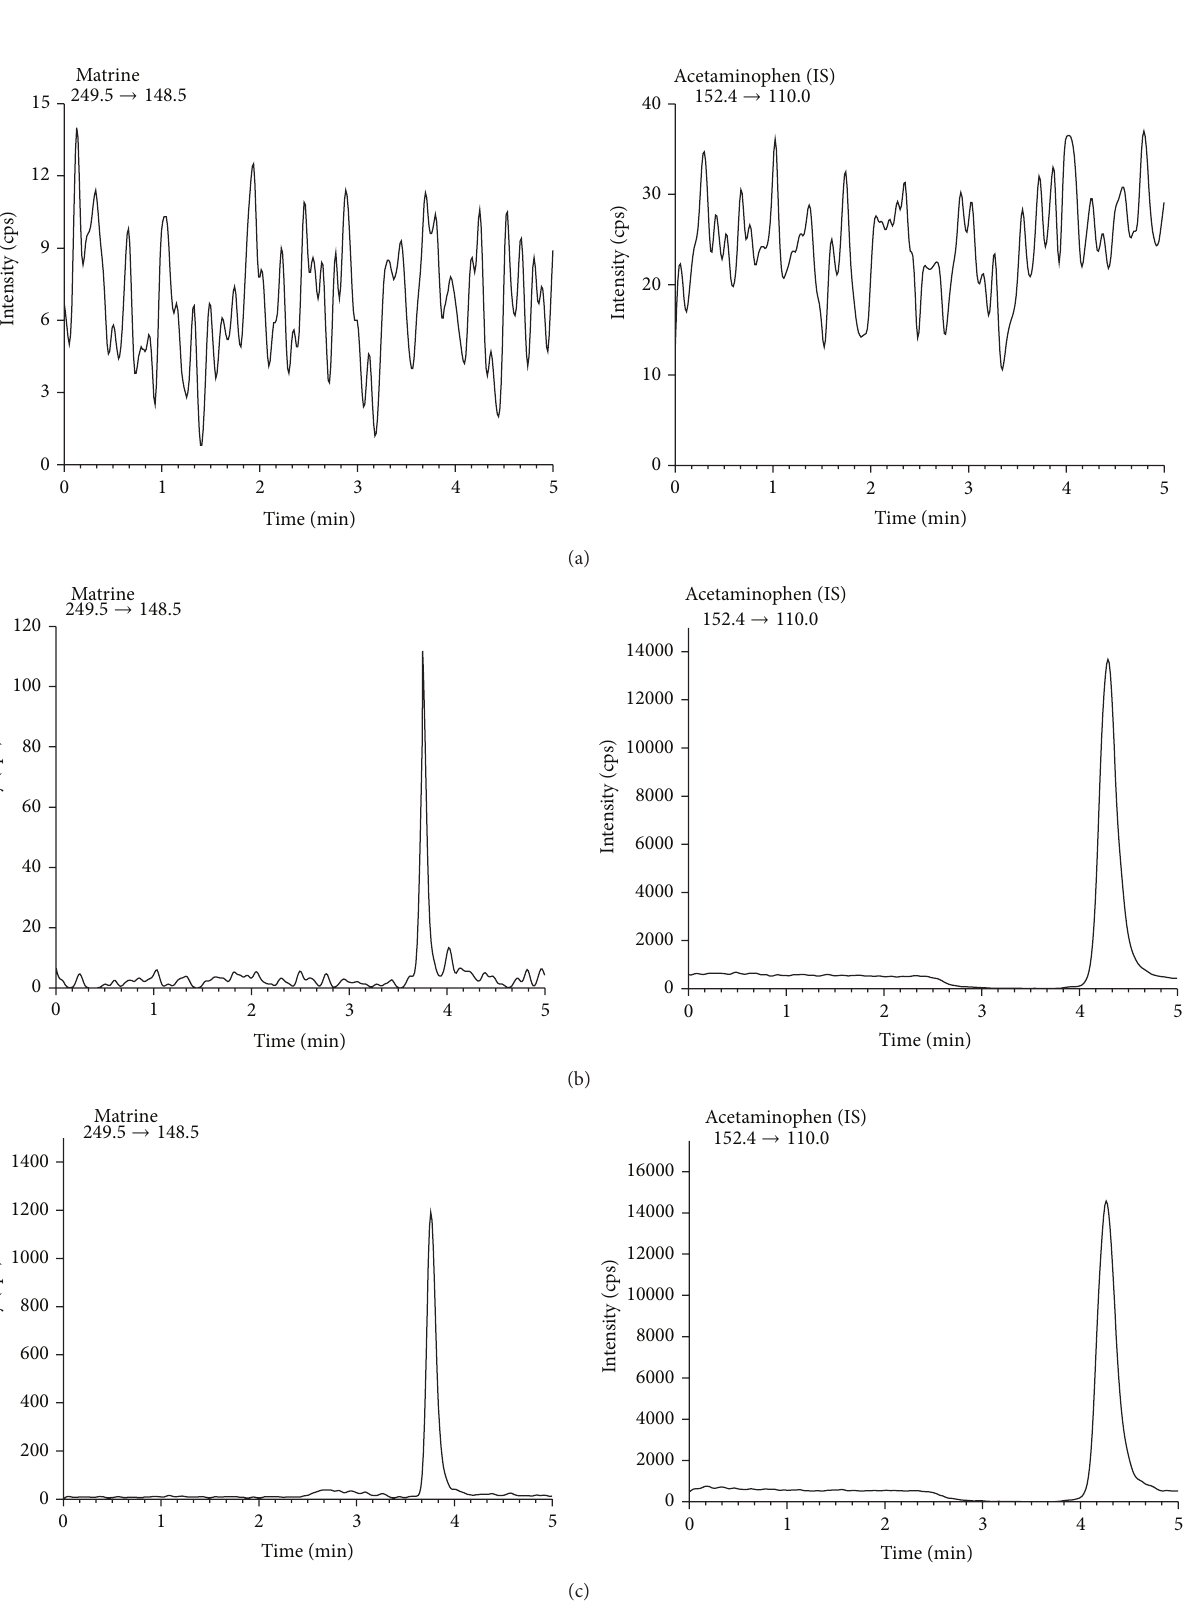
Figure 2: Chromatograms of rat blank plasma (a), rat plasma sample spiked with 10 ng/mL of matrine (LLOQ) (b), and a rat plasma sample obtained 2 hr after oral administration of KIOM-MA128 4g/kg